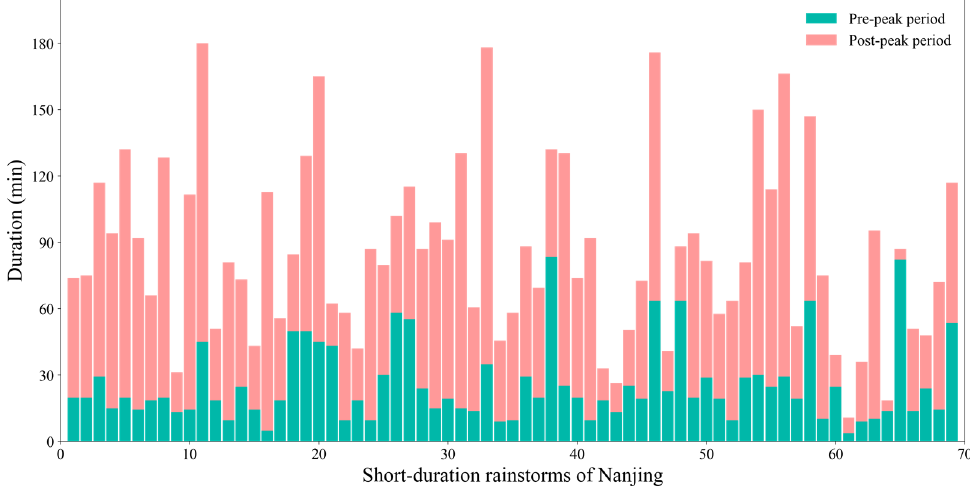
Figure 8. Frequency and duration of short-duration rainstorms over the last 60 years in Nanjing. Each color bar in Figure 8 represents a short-duration rainstorm event, and the length of the color bar represents the short-duration rainstorm’s duration, with the green portion representing the pre-peak period and the pink portion representing the post-peak period.